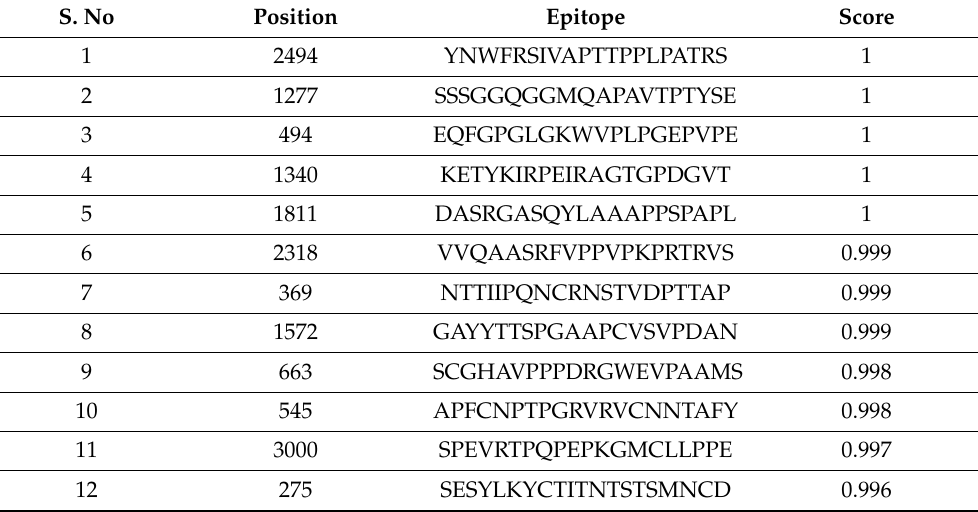
Table 3. Table of linear B-cell epitopes predicted by the BCPred